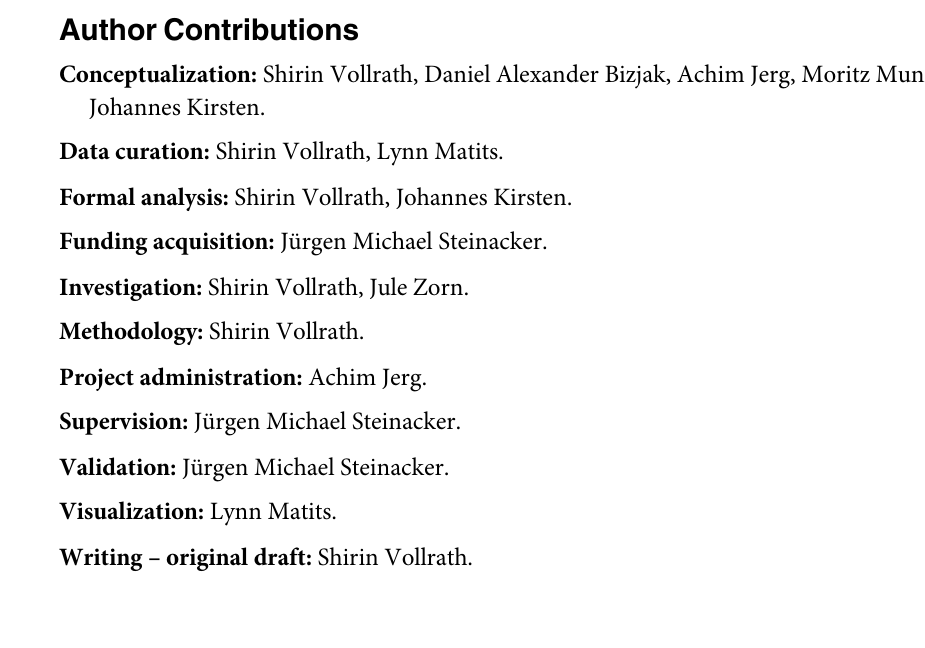
S4 Table. Test statistic for the Mann-Whitney-U test without confounder, considering time since infection or considering age. � for each test: df = 1Abbreviations: β : beta weight; Bf: Breathing frequency; lbm: Lean Body Mass; tsi: time since infection; VE: Ventilation; VE/ VCO2-Slope: Ventilation / Volume Carbon dioxide Slope; VO2: Volume Oxygen; Vt: Volume Tidal; Vt/VC: Tidal Volume / Vital